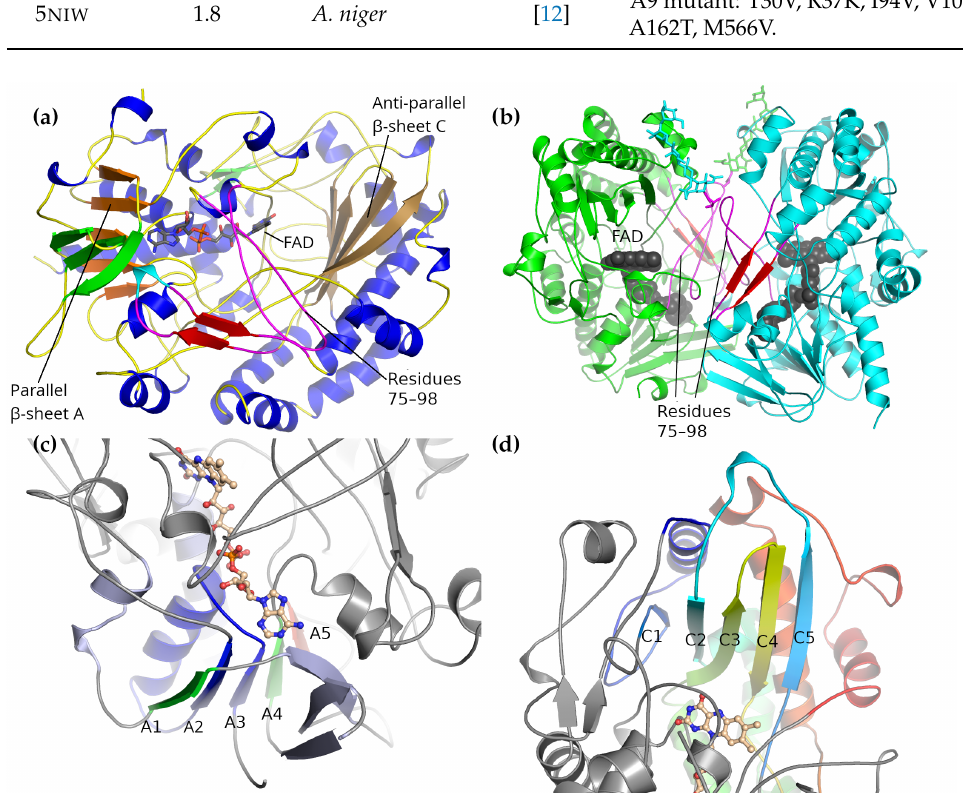
Figure 2. The overall structure of A. niger glucose oxidase. ( a ) The overall structure of the GOx monomer. The two central β -sheets are colored orange (parallel β -sheet A) and light brown (anti- parallel β -sheet C) and labeled. The two loops that participate in the dimer interface are colored magenta. ( b ) The GOx dimer. The two monomers are colored green and cyan, the FAD co-factor is shown as van der Waals spheres, the carbohydrate chains attached to Asn-89 that participate in the dimer interface are shown as sticks, and the loops that participate in the dimer interface are colored magenta. The more important of the two loops is labeled. ( c ) A closer view of parallel β -sheet A, which lies at the topological center of the enzyme. The β -sheet, together with the α -helix that forms part of the βαβ motif, is colored by residue from the N-terminus to the C-terminus based on sequence position to illustrate that all regions of the sequence take part in its formation. The α -helices and anti-parallel β -sheet that flank β -sheet A are shown in light blue. ( d ) A closer view of the anti-parallel β -sheet C, which forms a Greek-key motif. The residues surrounding β -sheet C form the second sub-domain and are colored by position from the N-terminal end to the C-terminal. The cytosolic-facing α -helices following β -strands C2 and C4 lie behind the central β -sheet in this view. All panels show the PDB structure 1 CF 3